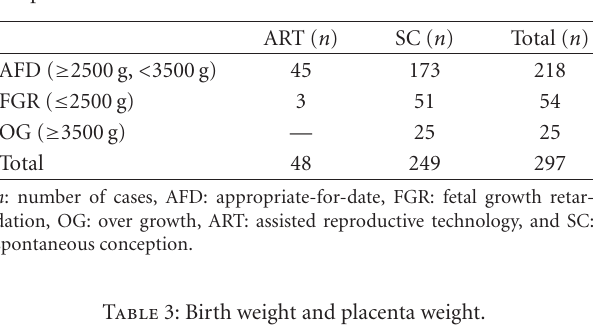
Table 2: Imprinted gene expression analysis in placental tissue samples.